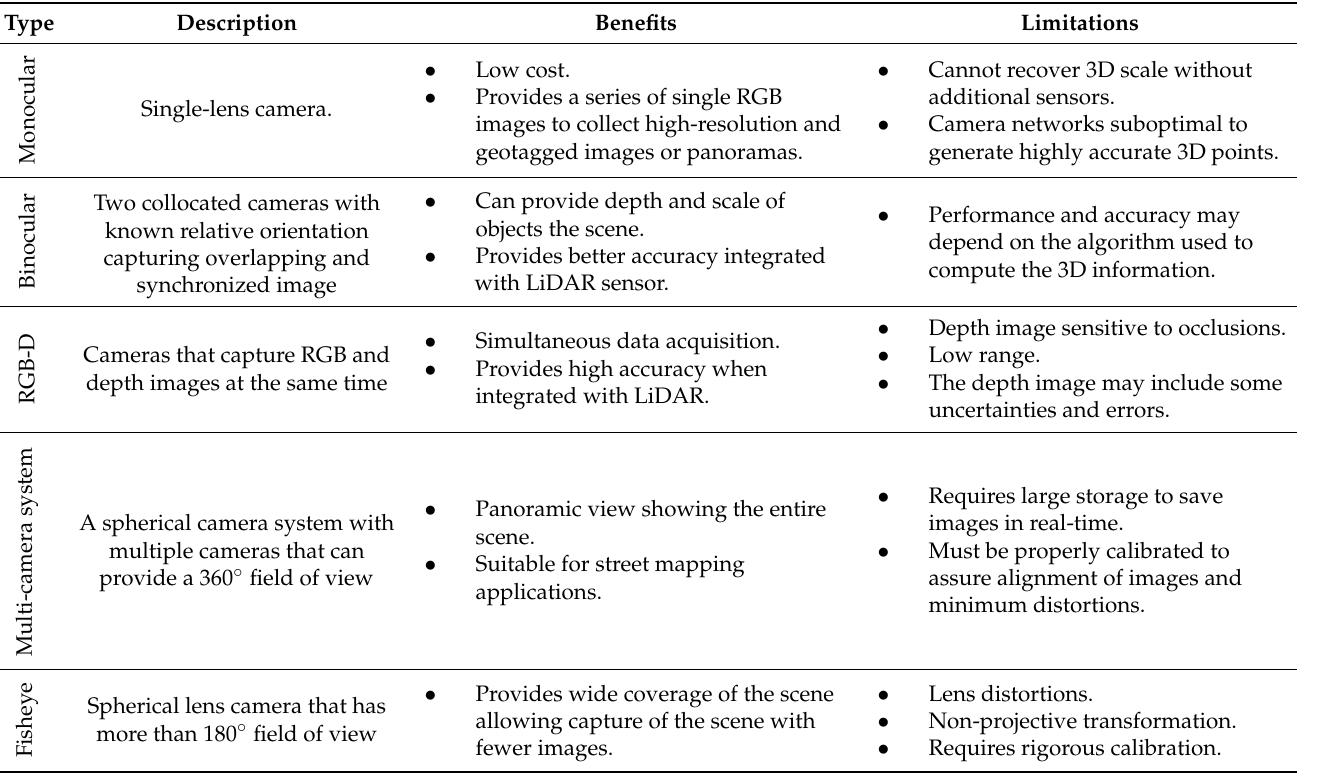
Table 3. Camera sensor